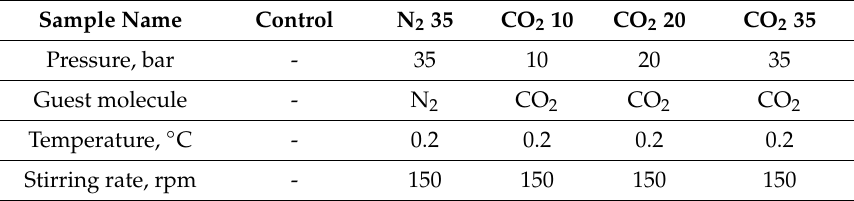
Table 1. Nomenclature and reaction condition of each